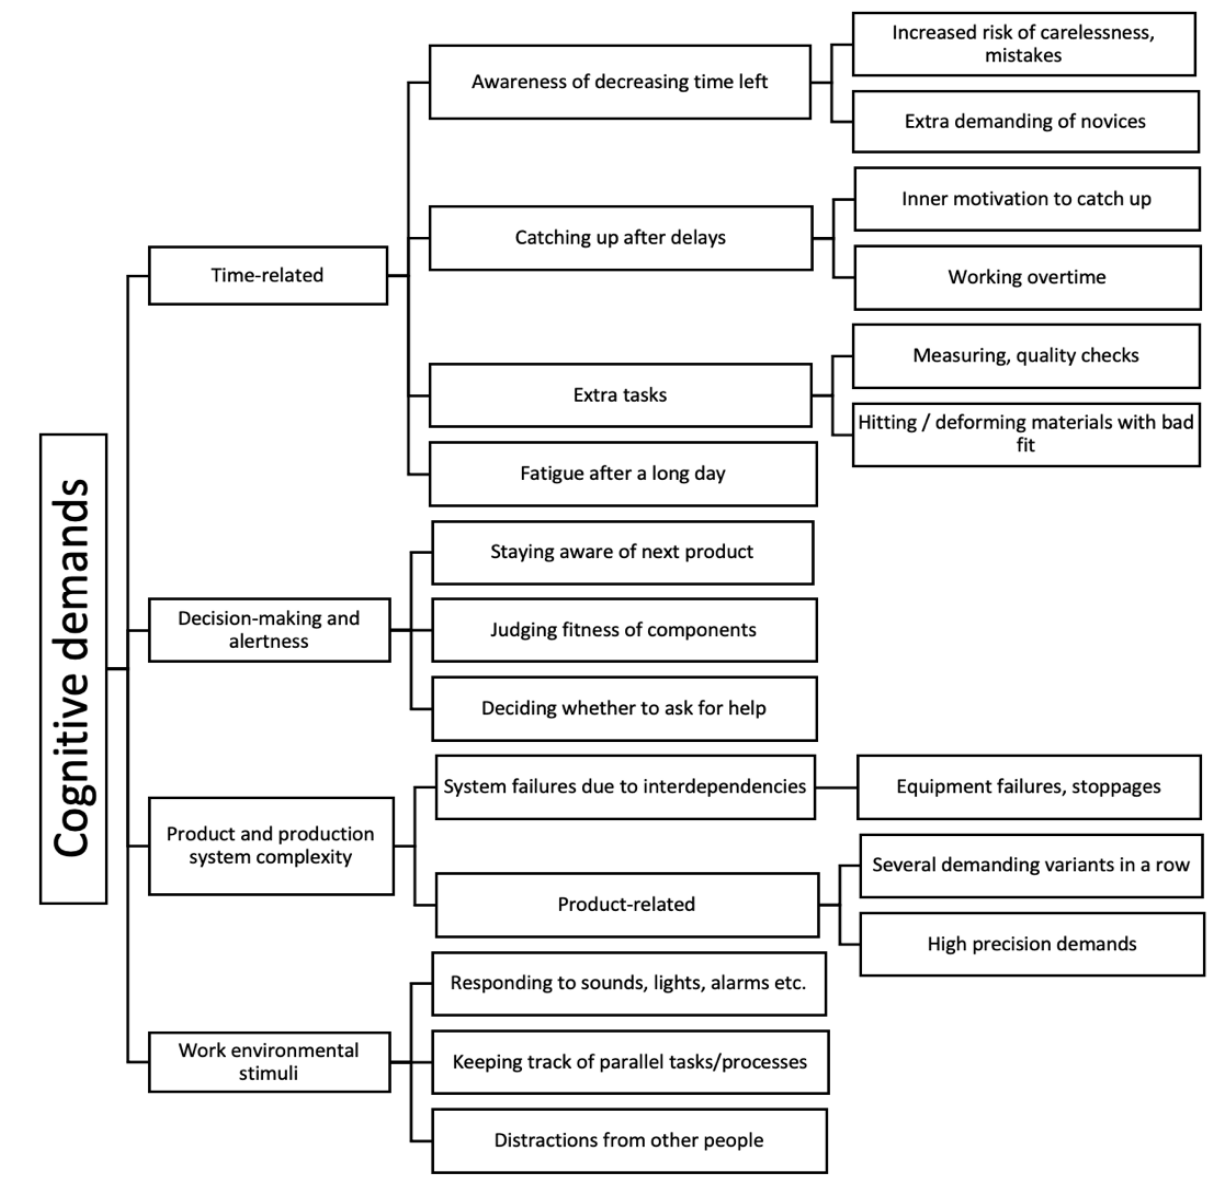
Figure 3. Cognitive demands.